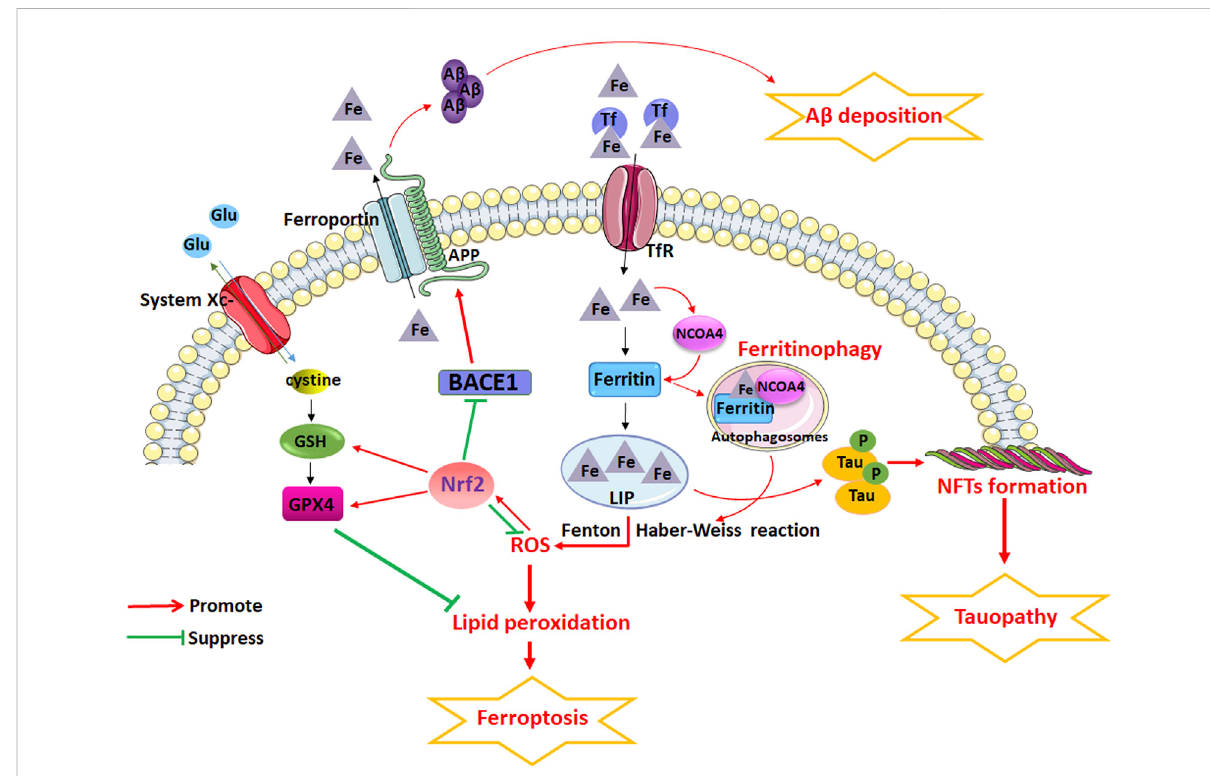
FIGURE 5 The potential role of iron dyshomeostasis and ferroptosis in AD. Iron dyshomeostasis contribute to senile plaques (SP) deposition and neuro fi brillary tangles (NFTs). Iron metabolism imbalance in brain and the dysfunction of endogenous antioxidant systems including system Xc- and glutathione peroxidase (GPX) are closely related to the etiopathogenesis of AD. Dysfunction of nuclear receptor coactivator 4 (NCOA4)-mediated ferritinophagy induced ferroptosis can accelerates the pathological process of AD. However, NRF2, through regulating the expression of a considerable number of genes related to ferroptosis, including genes related to iron and glutathione metabolism, plays an important role in the development of